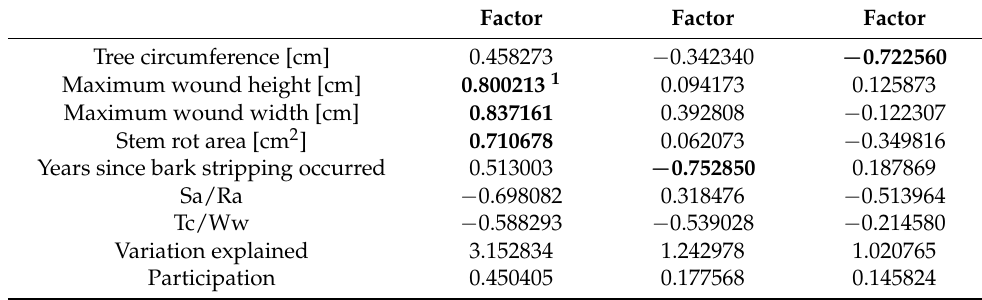
Table 4. Factor loads.